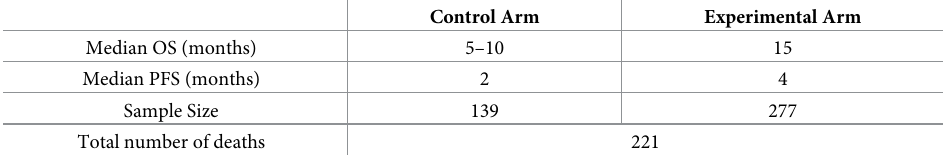
Table 1. Median OS, median PFS, sample size, and total number number of deaths based on the RECORD-1